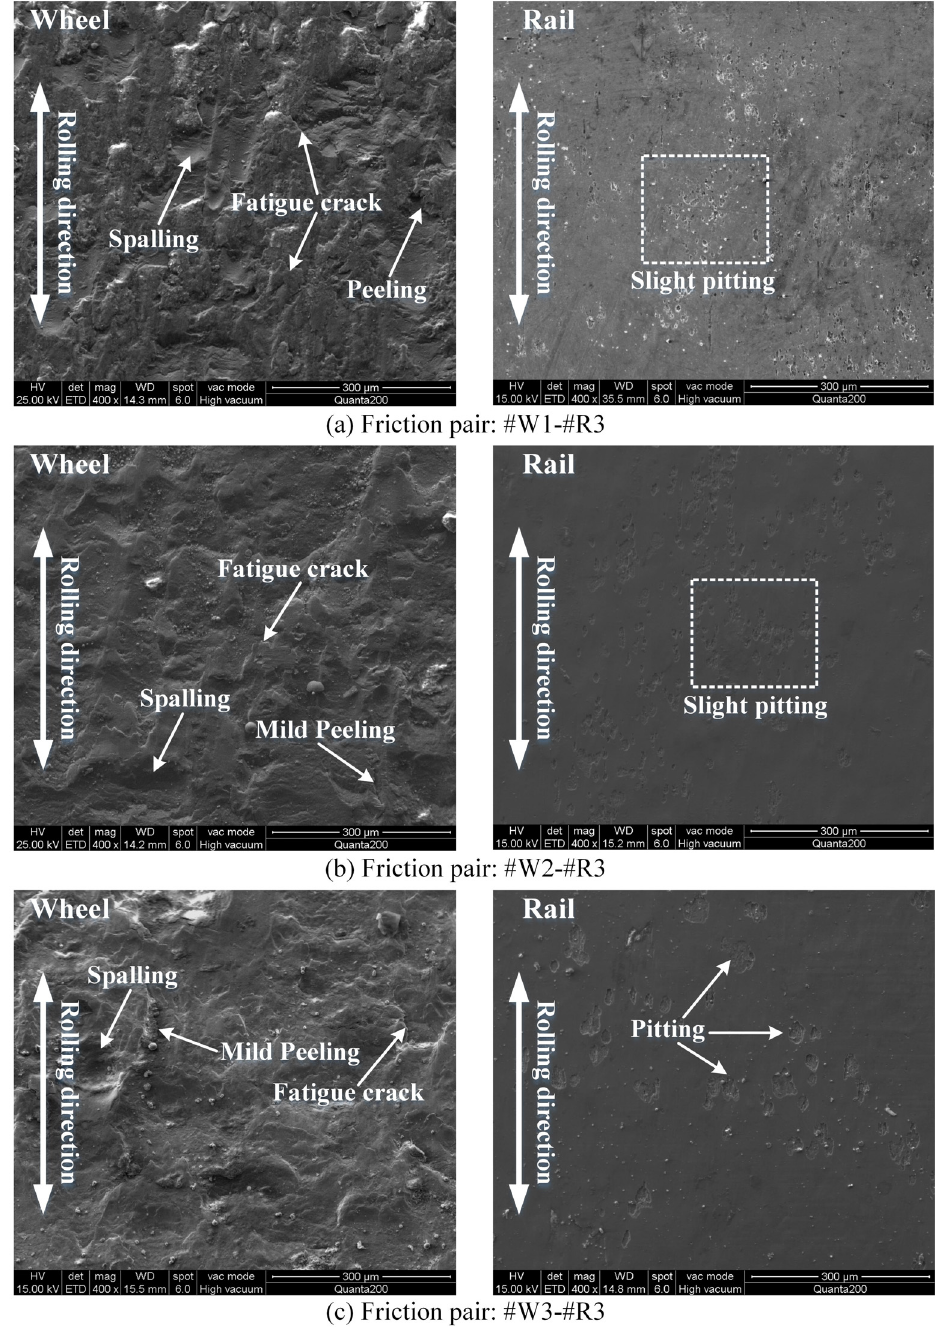
Figure 13. SEM micrographs of surface damage of the wheel/rail discs under different friction pairs: ( a ) #W1-#R3; ( b ) #W2-#R3; ( c ) #W3-#R3.